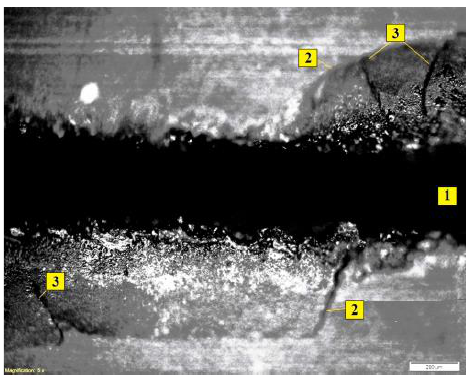
Figure 20. Chips and cracks in the EDM of oxide ceramics: ( 1 ) is the trace of the tool electrode; ( 2 ) is chips; ( 3 ) is cracks.